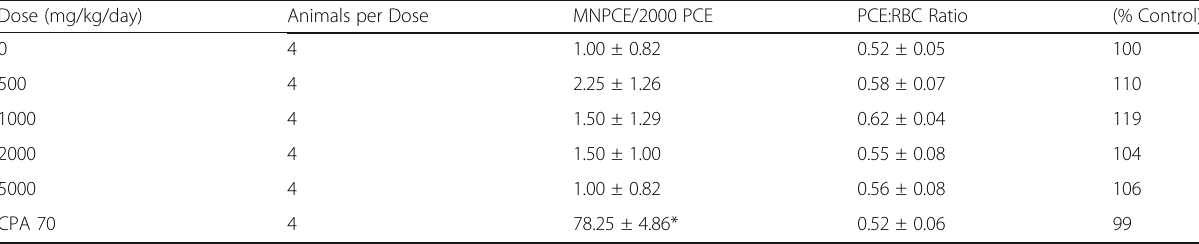
Table 7 Observations of micronucleus and PCE: RBC ratio – summary